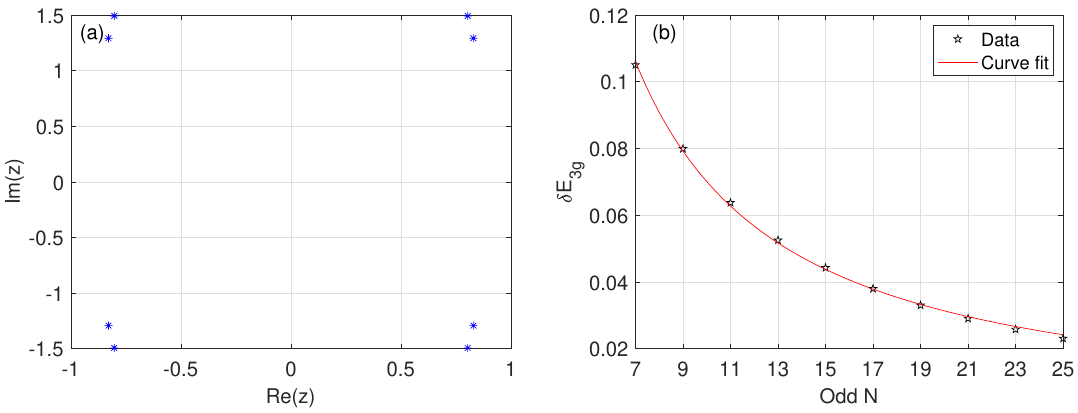
Figure 6 . (a) The distribution of z roots at the ground state for N = 9 and η = 0 . 75 + iπ . (b) The difference δE 3 g between the ground state energy calculated from eq. (5.11) and that obtained via numerical exact diagonalization. The data can be fitted as δE 3 g = 1 . 016 N − 1 . 161